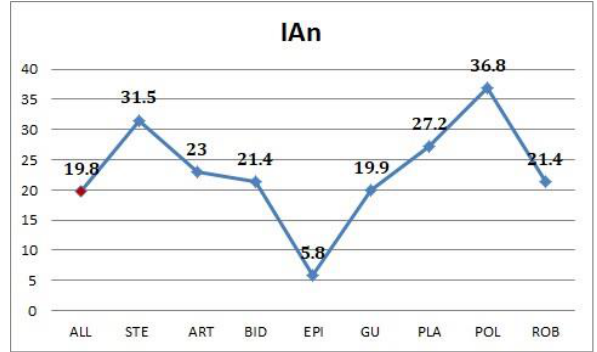
Fig. 1. Anthropogenization (IAn) indices of the ruderal phytocoenoses of Ukraine